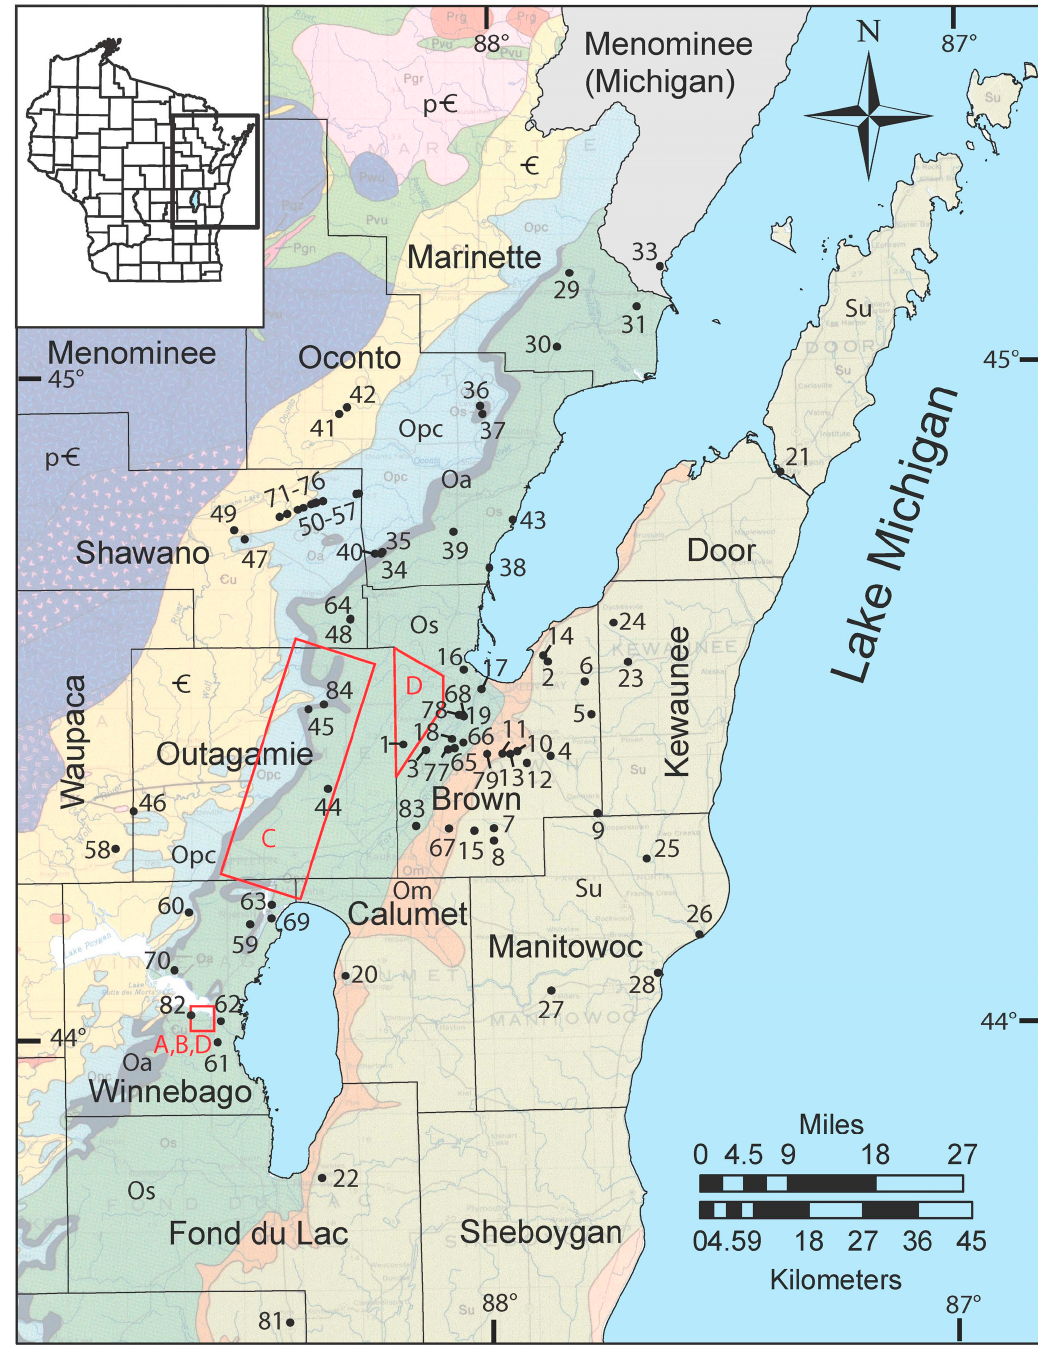
Figure 3. Map with sample locations (outcrops, quarries, drill cores, well cuttings) throughout the study area in northeastern Wisconsin. Thin lines and names indicate county boundaries. Inset map shows the study area location in the state of Wisconsin, USA. Red areas with letters indicate groundwater studies performed in the region (A is reference for Gotkowitz et al. [29], B is Thornburg and Sahai [30], C is Burkel and Stoll [31], and D is Schreiber et al. [32]). Additional references for region-wide studies include Riewe et al. [33] and Johnson and Riewe [34], as well as a cancer study by Knobeloch et al. [35] that focused on Winnebago and Outagamie counties. Base map after Mudrey et al. [36] shows the following units: p Є = Precambrian, Є = Cambrian sandstones, Opc = Ordovician Prairie du Chien Group, Oa = Ordovician Ancell Group, Os = Ordovician Sinnipee Group, Om = Ordovician Maquoketa-Neda formations, and Su = Silurian dolostones.